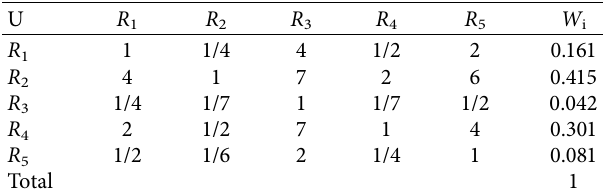
Figure 3: Performance evaluation flowchart of IEE in all kinds of colleges and universities. Table 3: Weight of the first-level indicators.